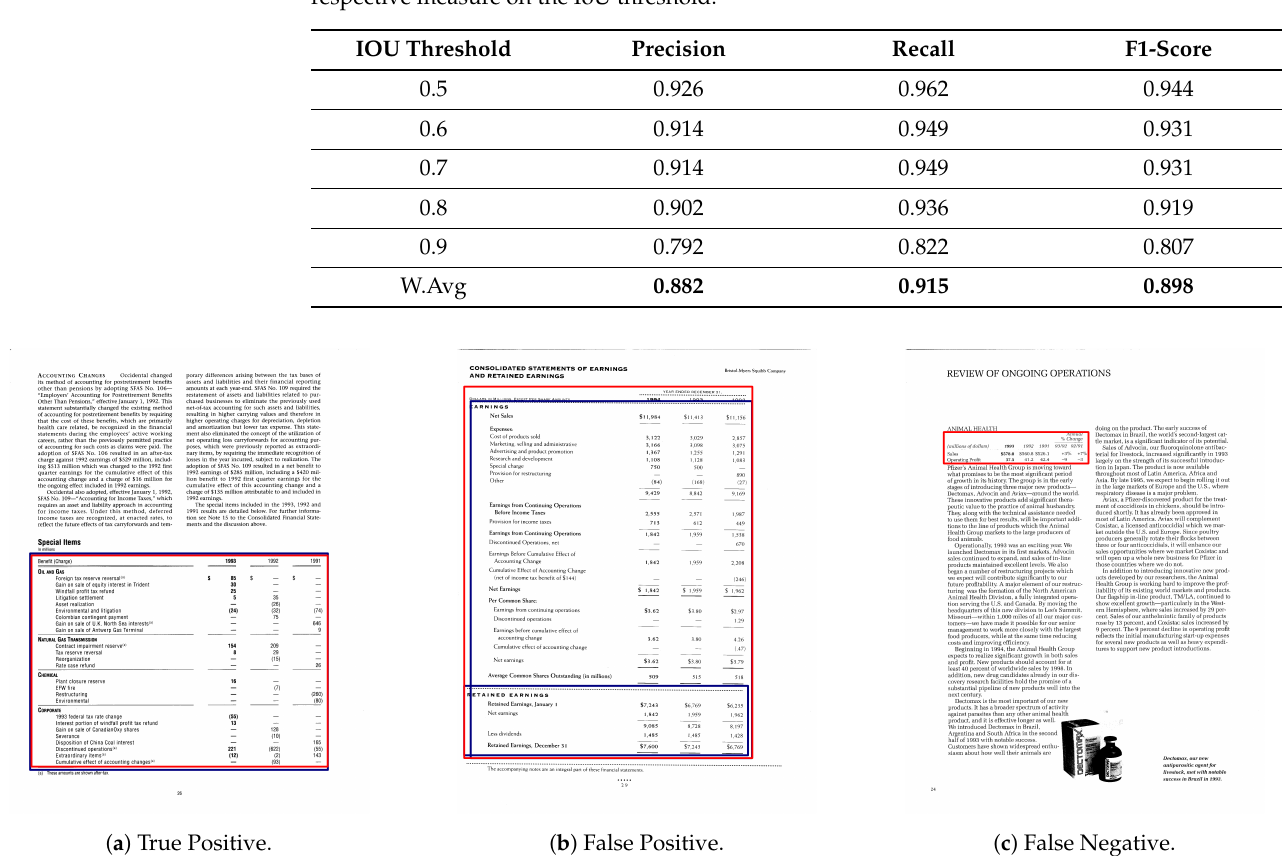
Figure 10. HNet results on UNLV dataset. ( a – c ) True positive, False positive, and False negative results, respectively. The blue outline shows the predicted table, and the red outline highlights the ground truth